Question: Give a one-sentence summary of this figure.
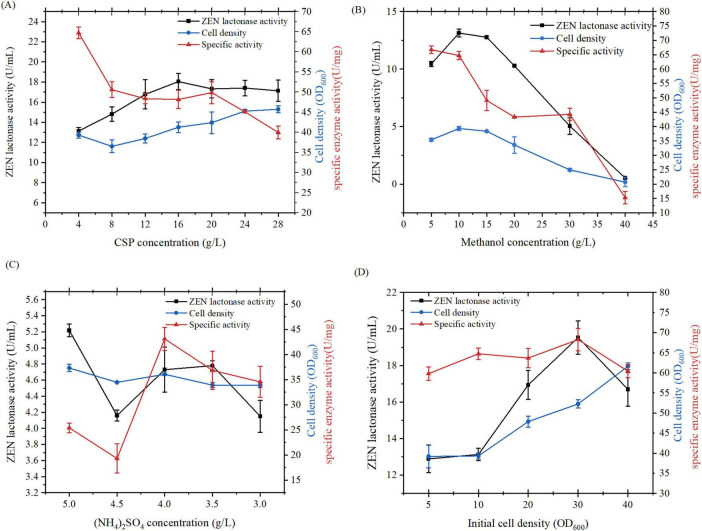
Answer: Single-factor optimization of (A) CSP concentration, (B) methanol concentration, (C) (NH 4 ) 2 SO 4 concentration, and (D) initial cell density. The optimal CSP concentration was 16 g/L, methanol concentration 10 g/L, (NH 4 ) 2 SO 4 concentration 5 g/L, and initial cell density OD 600 = 30 for maximum enzyme activity.